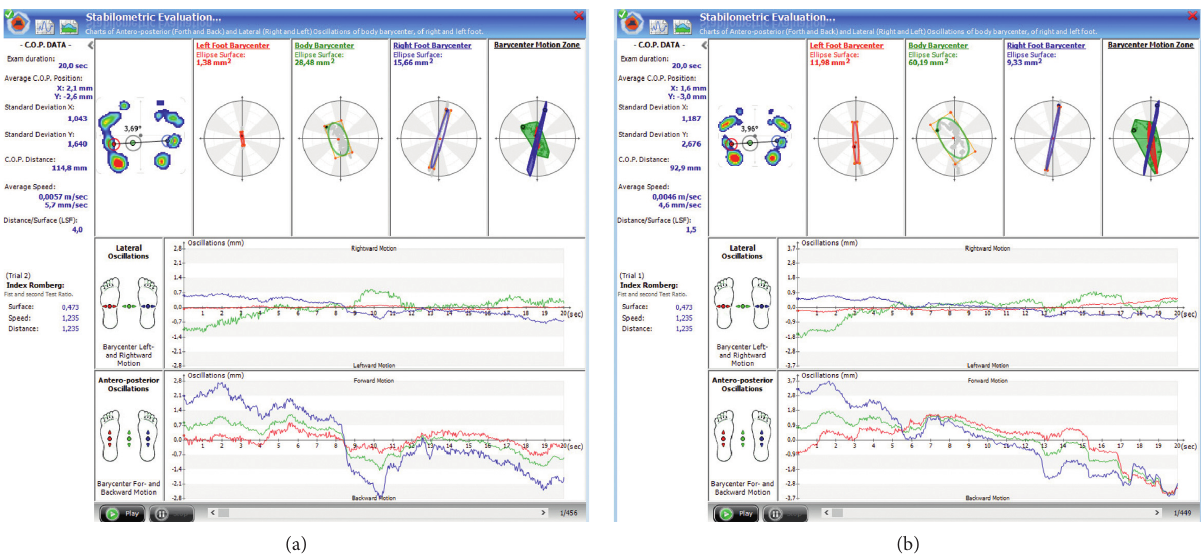
Figure 6: The exemplary result of a balance (stabilometric) examination performed at a therapeutic session.